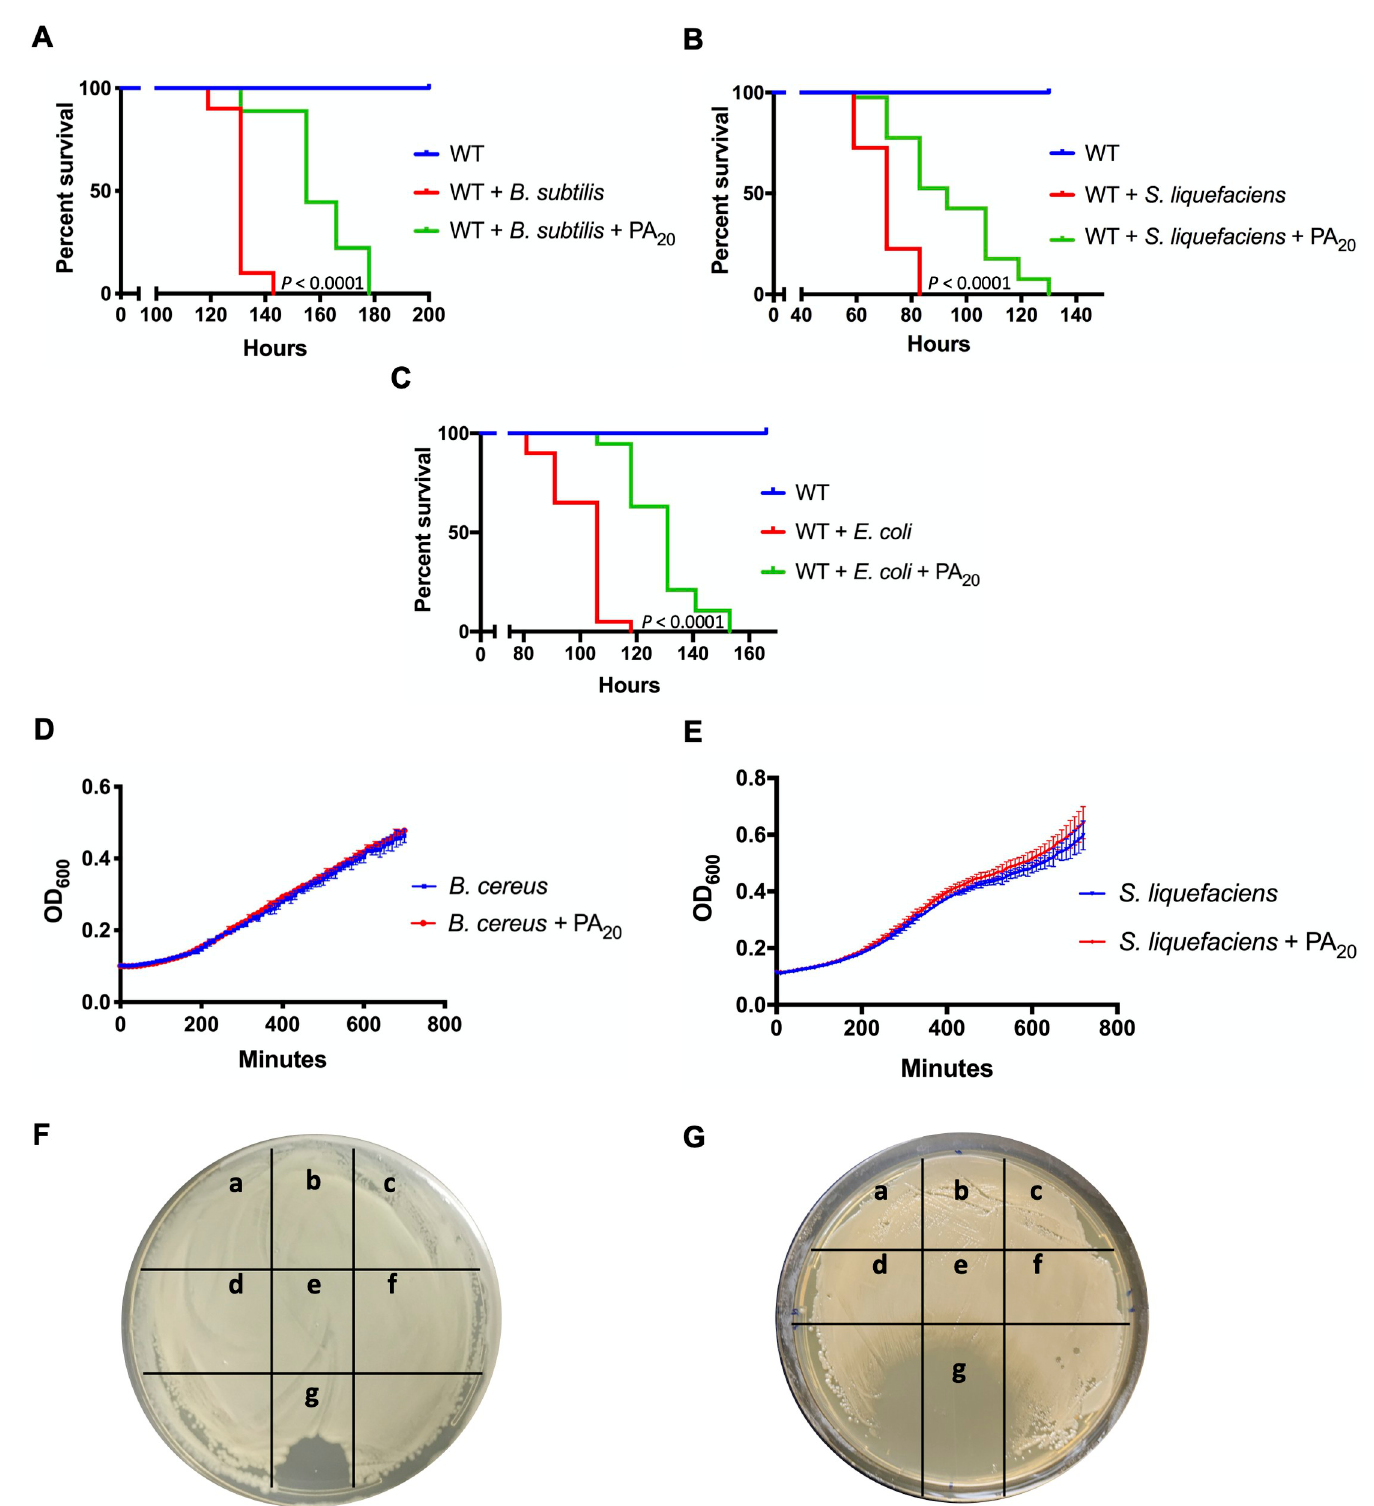
Fig 4. PA 20 protection is broad-spectrum and insect-directed. (A-C) The effect of PA 20 on the sensitivity of flies to other bacteria. WT flies were infected with B . subtilis (A), S . liquefaciens (B), and E . coli (C) without or with PA 20 . P as in Fig 1. (D-G) PA 20 does not alter the growth of B . cereus and S . liquefaciens . (D-E) The ability of PA 20 to affect the rate of B . cereus (D) and S . liquefaciens (E) growth in LB and TSB, respectively. The bacterial growth was measured in a liquid medium in a 96-well plate with and